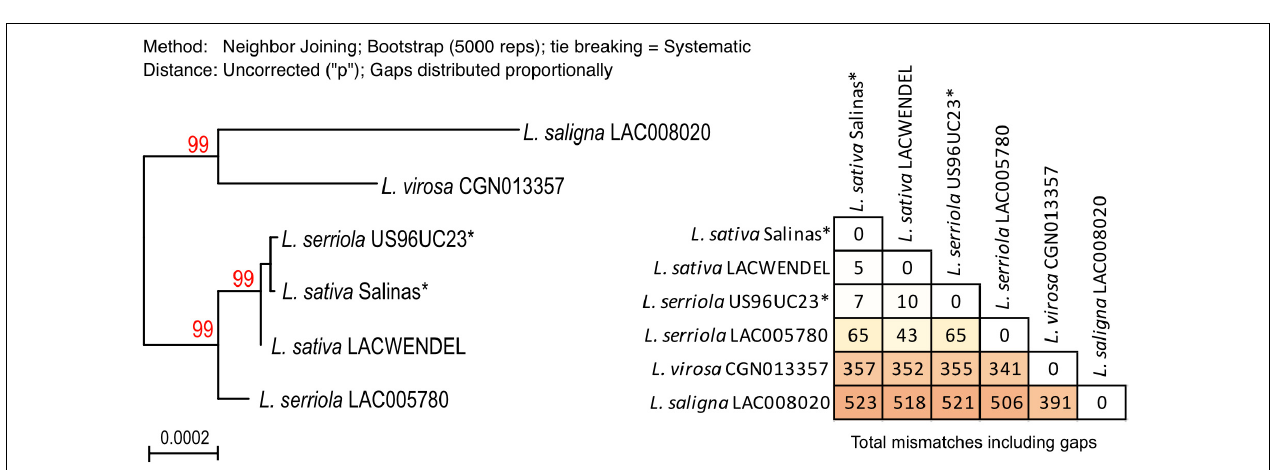
FIGURE 5 | Structural diversity between the mitochondrial genomes of Lactuca spp. Alignments between Lactuca mtDNAs made with progressive Mauve . (A) Between L. sativa, L. saligna, L. virosa and L. serriola . (B) Between L. sativa, the L. serriola mtDNAs built in our study and the mtDNA of L. serriola US96UC23 published by Kozik et al. (2019). Homologous regions delimited by repeated regions are shown in the same color according to the six blocks (A–F) that subdivide the L. sativa mtDNA. Repeated sequences involved in structural evolution between the genomes are represented, according to the key on the left. Scale is in kilobases.